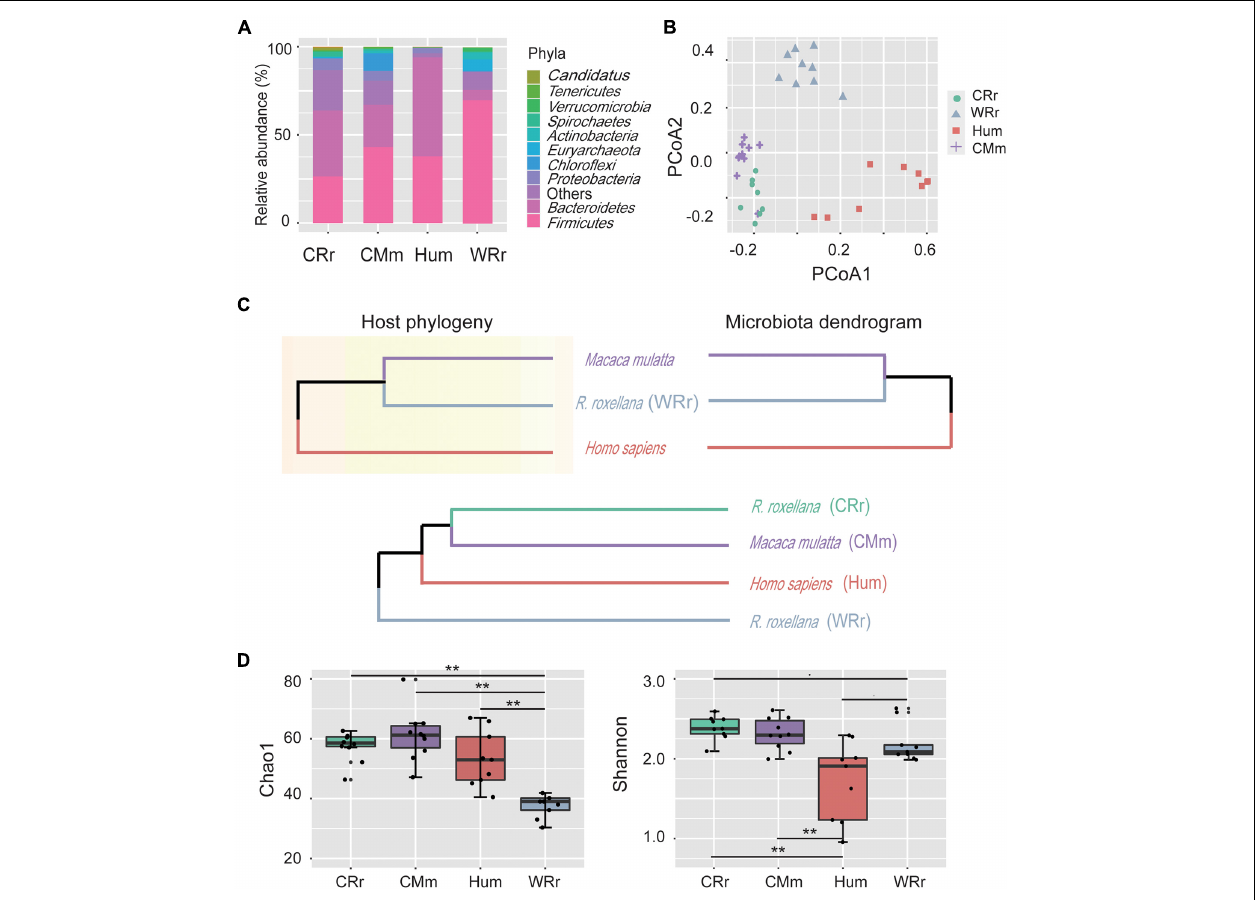
FIGURE 1 | Community constituents, structure, richness, and diversity of the gut microbiome among all cohorts. (A) Compositional bar plot of the ten most abundant phyla in each cohort (WRr: wild R. roxellana ; CRr: captive R. roxellana ; Hum: humans; CMm: captive M. mulatta ). (B) PCoA plot of the gut microbiome community composition in the four cohorts at the genus level. (C) Comparison of the host phylogeny (upper left panel; assembled using http://timetree.org/) and their hierarchical tree (upper right panel). The gut microbiome dendrogram of the four cohorts (lower panel). (D) Alpha diversity of the gut microbiome in the four cohorts and [ p (FDR) -value ] between cohorts. Two asterisk indicates significant differences ( p (FDR)-value < 0.01). Panel (A–D) indicate the tremendous effects of captivity and lifestyle on captive monkeys, and the gut microbiome of captive monkeys was more similar to that of humans than to that of wild monkeys.